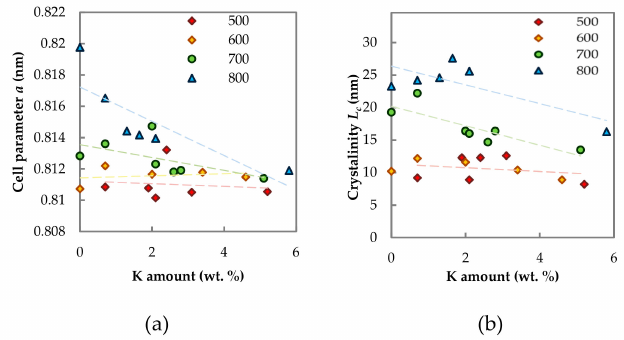
Figure 3. Dependence of ( a ) spinel lattice parameter a on K amount and ( b ) crystallinity L c on K amount. The numbers in the legend mean the calcination